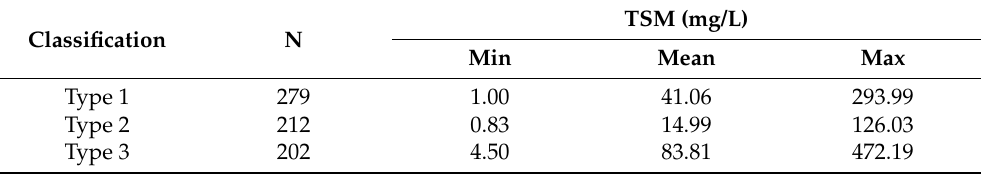
Table 2. Statistics of TSM concentration for different optical water